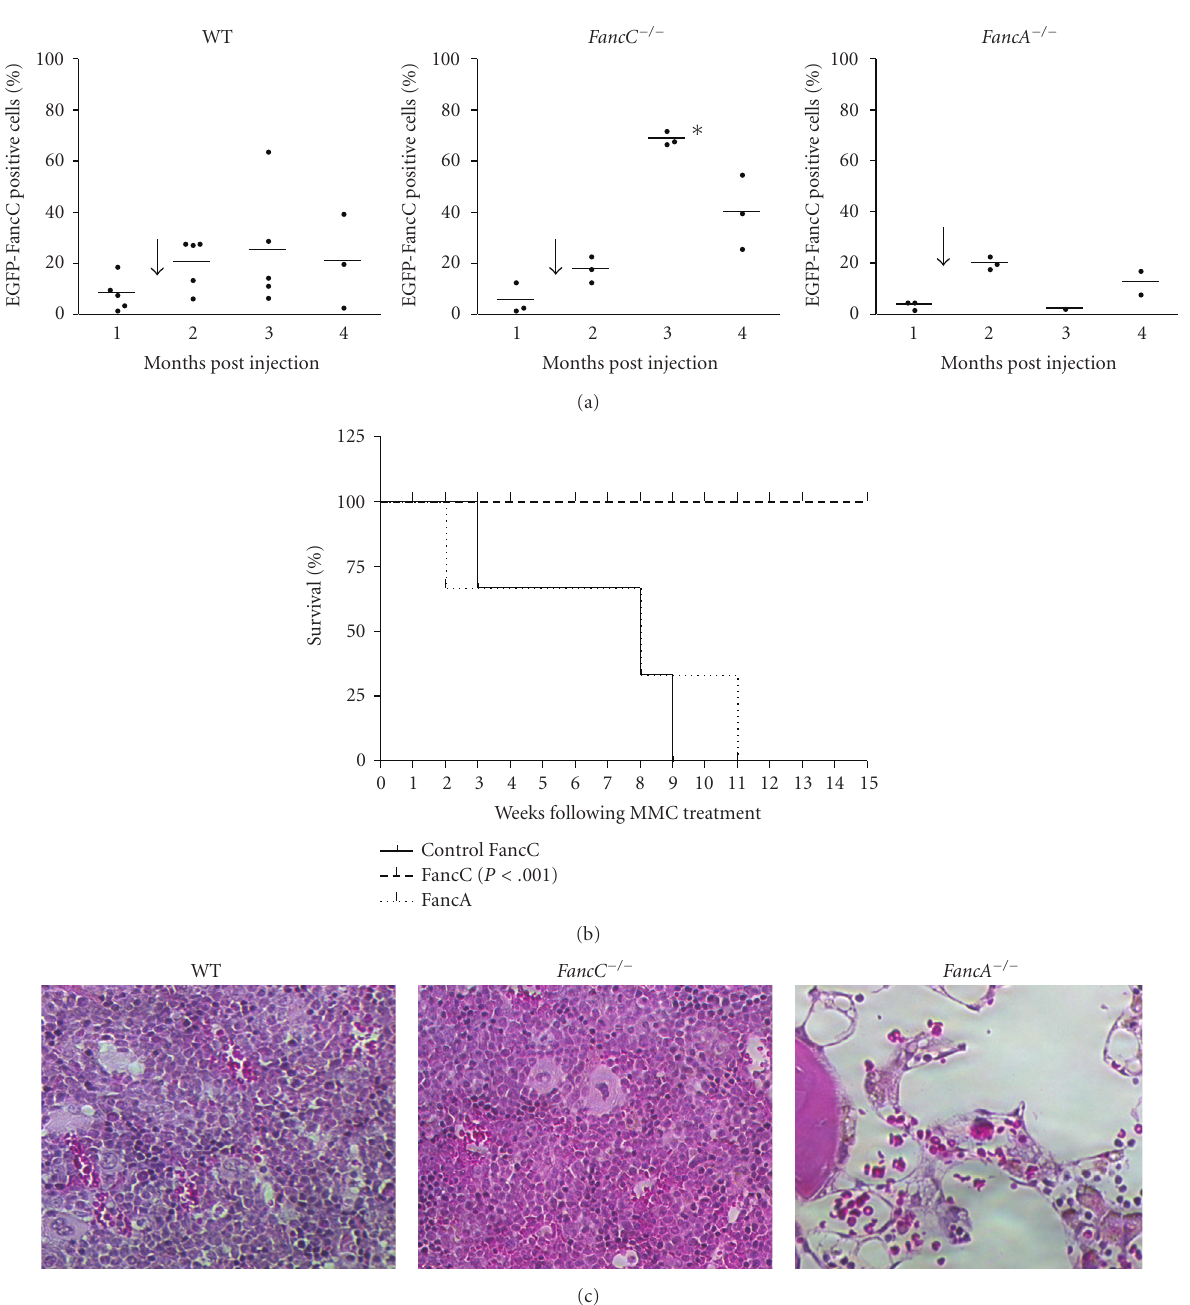
Figure 3: Intrafemoral gene transfer prevents MMC-induced BM aplasia. (a) FancC-EGFP transgene expression in peripheral blood cells of IF-injected wild type (WT), FancC − / − , and FancA − / − mice as a function of time. Each dot represents the FancC-EGFP expression of an individual IF-injected mouse. The arrow represents the start of weekly MMC injections (0.3mg/kg). Horizontal line: mean value. ∗ P < . 02. (b) Survival curves of IF-injected FancC − / − ( n = 5) and FancA − / − ( n = 3) mice following MMC treatments. Control FancC − / − mice represent uninjected mice treated weakly with MMC ( n = 22). (c) Representative histological appearances of the sternum from injected mice after 15 weeks of MMC treatment. Hematoxylin-eosin staining: original magnification 200 × . injections), but dramatically increased in all FancC − / − IF- injected mice compared to both WT and FancA − / −